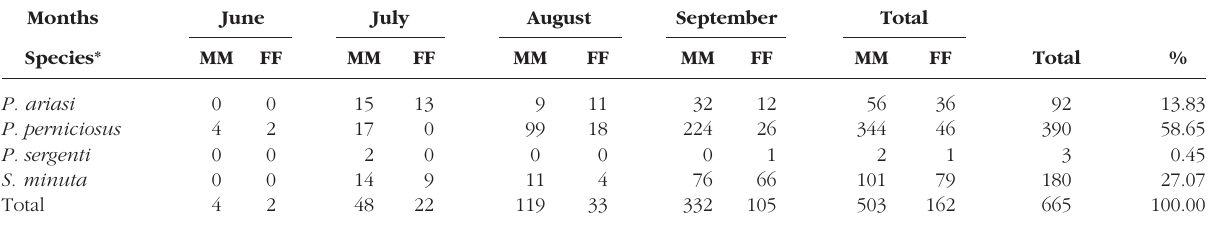
Table II. – Abundance of P. ariasi , P. perniciosus , P. sergenti and S. minuta observed in